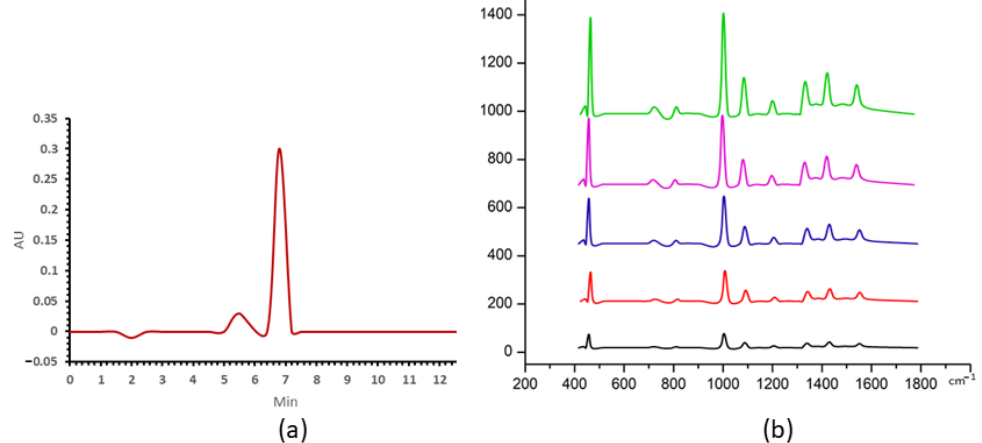
Figure 3. ( a ) The uric acid HPLC peak at concentration of 50 μ g/mL, ( b ) SERS spectra of uric acid for concentrations at 5, 10, 20, 25, 50 μ g/mL in black, red, blue, purple and green, respectively.